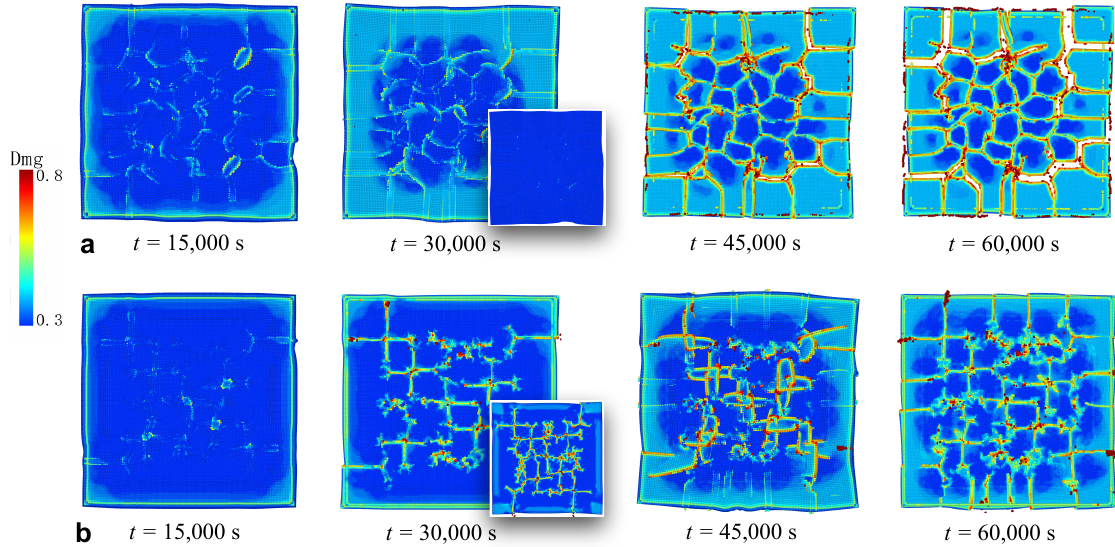
Figure 4. The processes of crack formation and propagation in the continuous Si film during lithiation/delithiation cycles. ( a ) Snapshots in the case of one cycle in 60,000 s. ( b ) Snapshots in the case of two cycles in 60,000 s. The snapshots depict the view from the interface on the bottom of the film. The insets at t = 30,000 s are snapshots on the top free surface at the same moments. Colors represent the degrees of